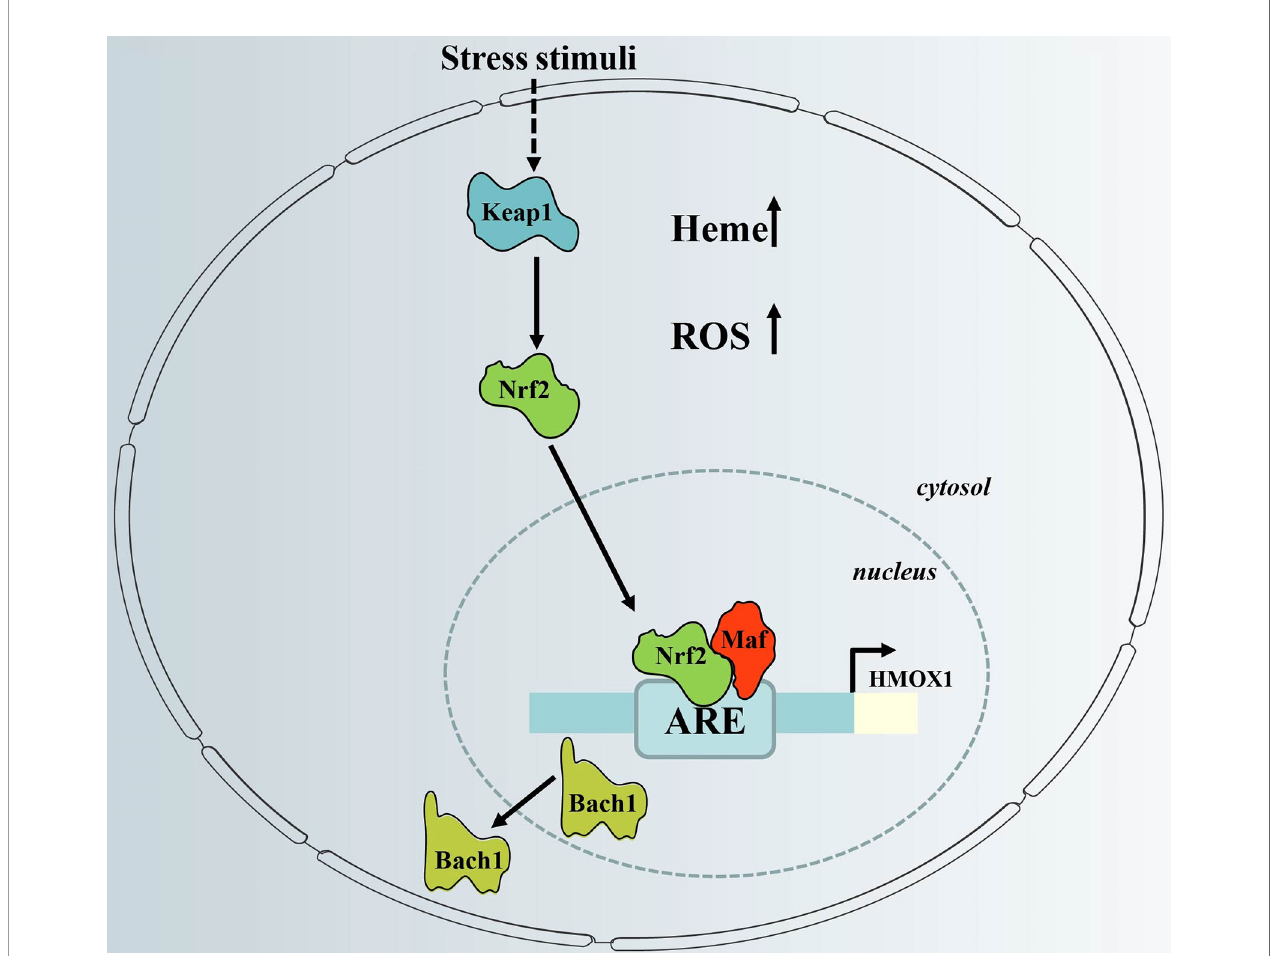
FIGURE 2 | Regulation of HO-1 gene expression via the redox-dependent Keap1-Nrf2 system. HO-1 gene expression is regulated via inactivation of Bach1 and activation of Nrf2, which have counter-regulatory functions. When cellular heme levels are high, and in response to stress stimuli, Bach1 is removed from the HO-1 promoter. In addition, stress stimuli cause dissociation of Nrf2 from Keap1, which activates HO-1 gene expression after nuclear translocation via binding to HO-1 ARE. ARE, antioxidant response element; Keap1, Kelch-like ECH-associated protein 1; HMOX1, HO-1 gene; Bach1, BTB and CNC homologue 1; Nrf2, nuclear factor erythroid-related factor 2; ROS; reactive oxygen